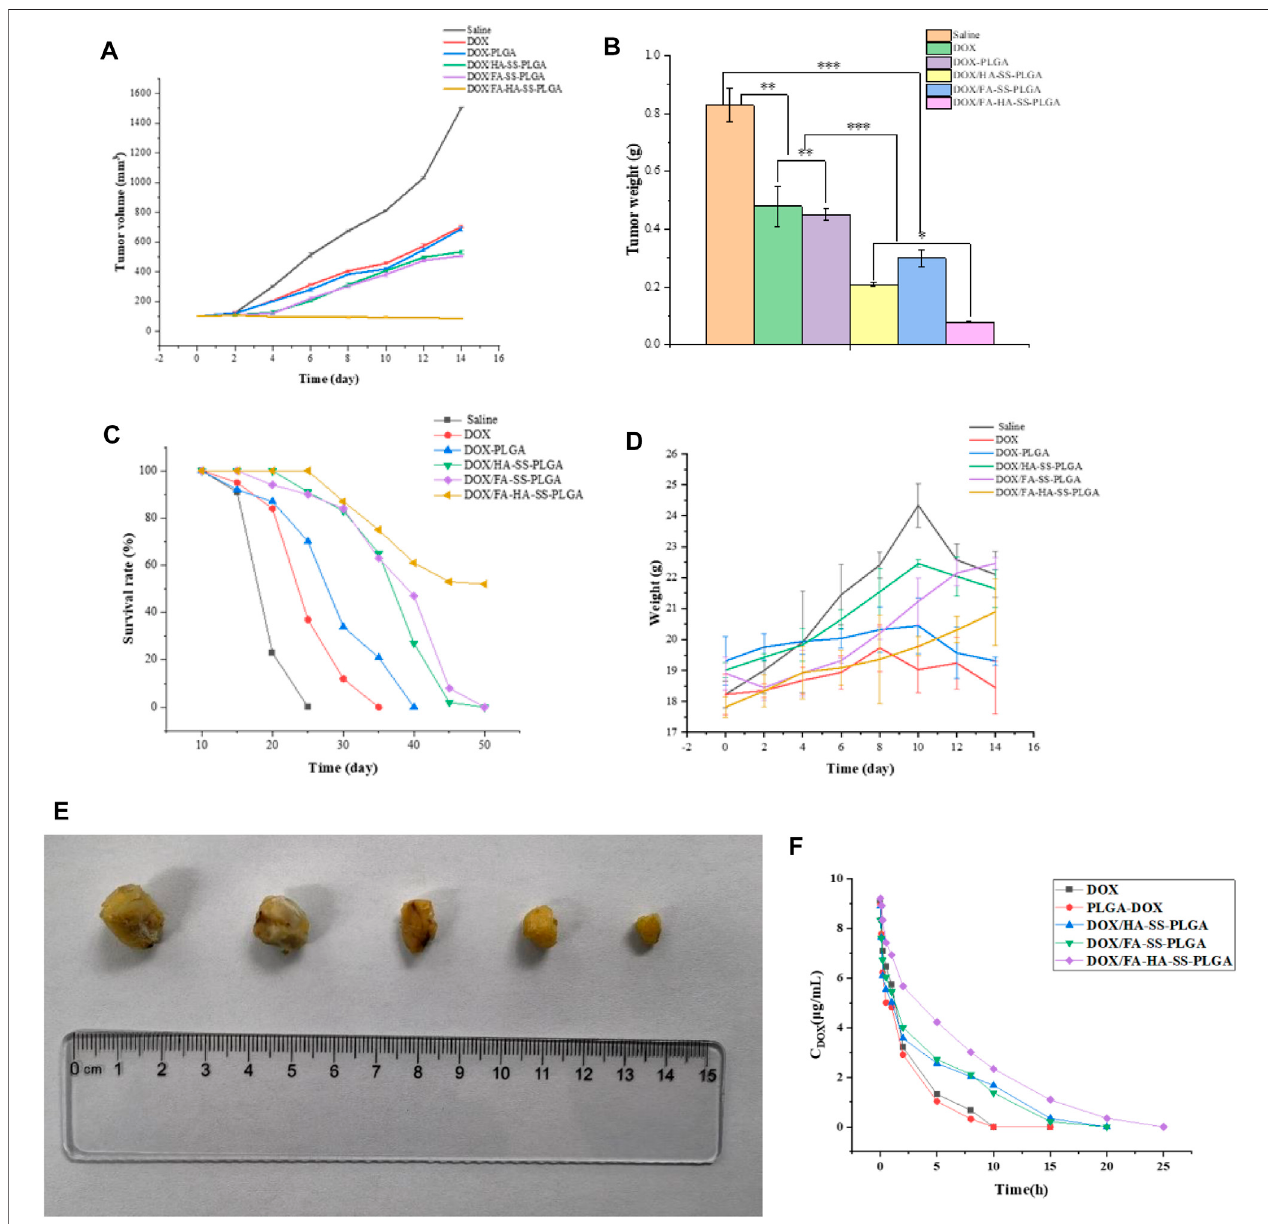
FIGURE10|(A) Thetumor growthvolume aftertreatmentwithsaline, DOX,DOX-PLGA,DOX/HA-SS-PLGA,DOX/FA-SS-PLGA, and DOX/FA-HA-SS-PLGA. (B) Tumor weight after treatment with saline, DOX, DOX-PLGA, DOX/HA-SS-PLGA, DOX/FA-SS-PLGA, and DOX/FA-HA-SS-PLGA (* p < 0.05; ** p < 0.01; *** p < 0.001). (C) Survivalrateofmice aftertreatmentwithsaline, DOX,DOX-PLGA,DOX/HA-SS-PLGA,DOX/FA-SS-PLGA, andDOX/FA-HA-SS-PLGA. (D) Changesinbodyweight of nude mice during experiment. (E) Tumor morphology after experiment. (F) Pharmacokinetics of various preparations in mice. Data were expressed as mean ± SEM ( n =